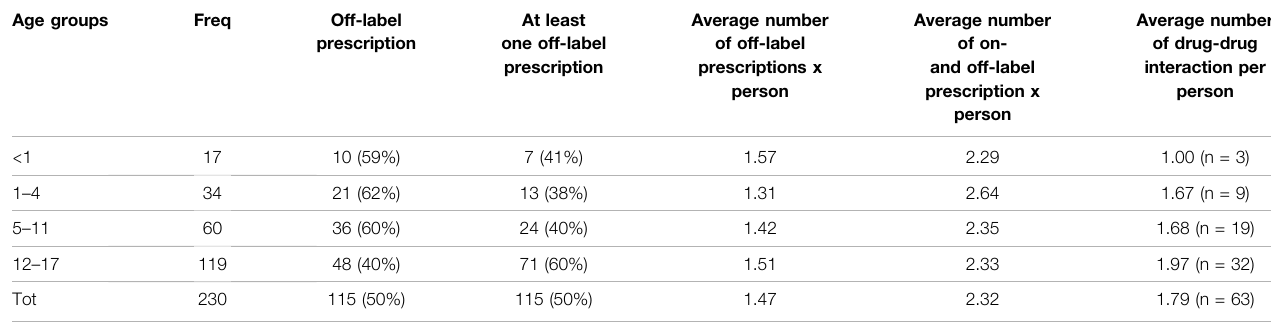
TABLE 4 | Description of prescribing patterns.